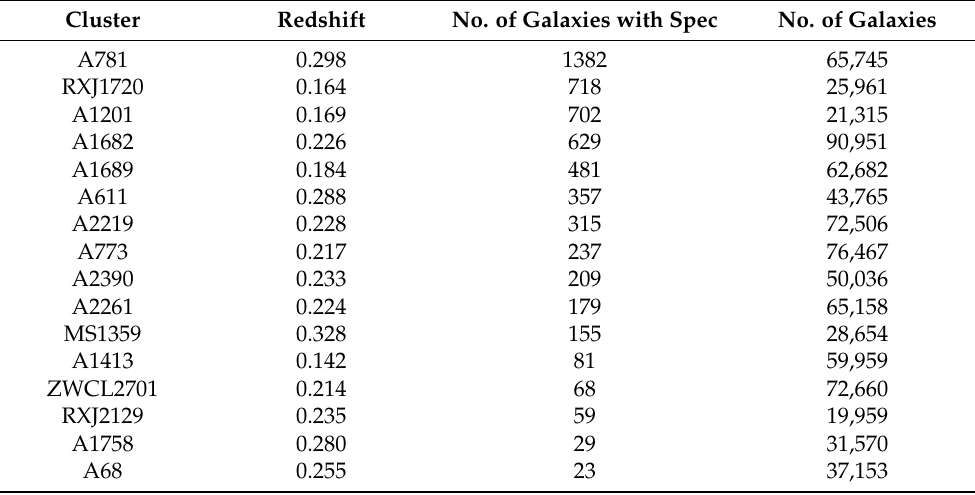
Table 1. Cluster sample. No. of Galaxies with Spec is the number of galaxies in our Subaru sample with available NED spectroscopic